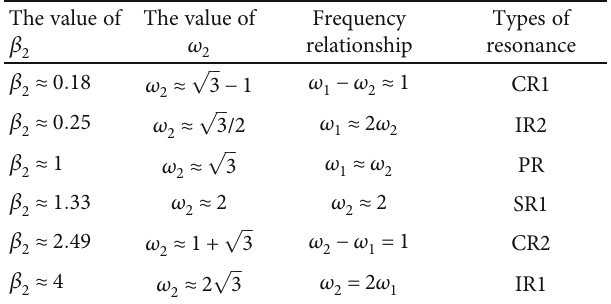
Figure 2: The relation curves between β resonance type. Table 2: The values of parameter β resonance type at β 1 = 0 : 001